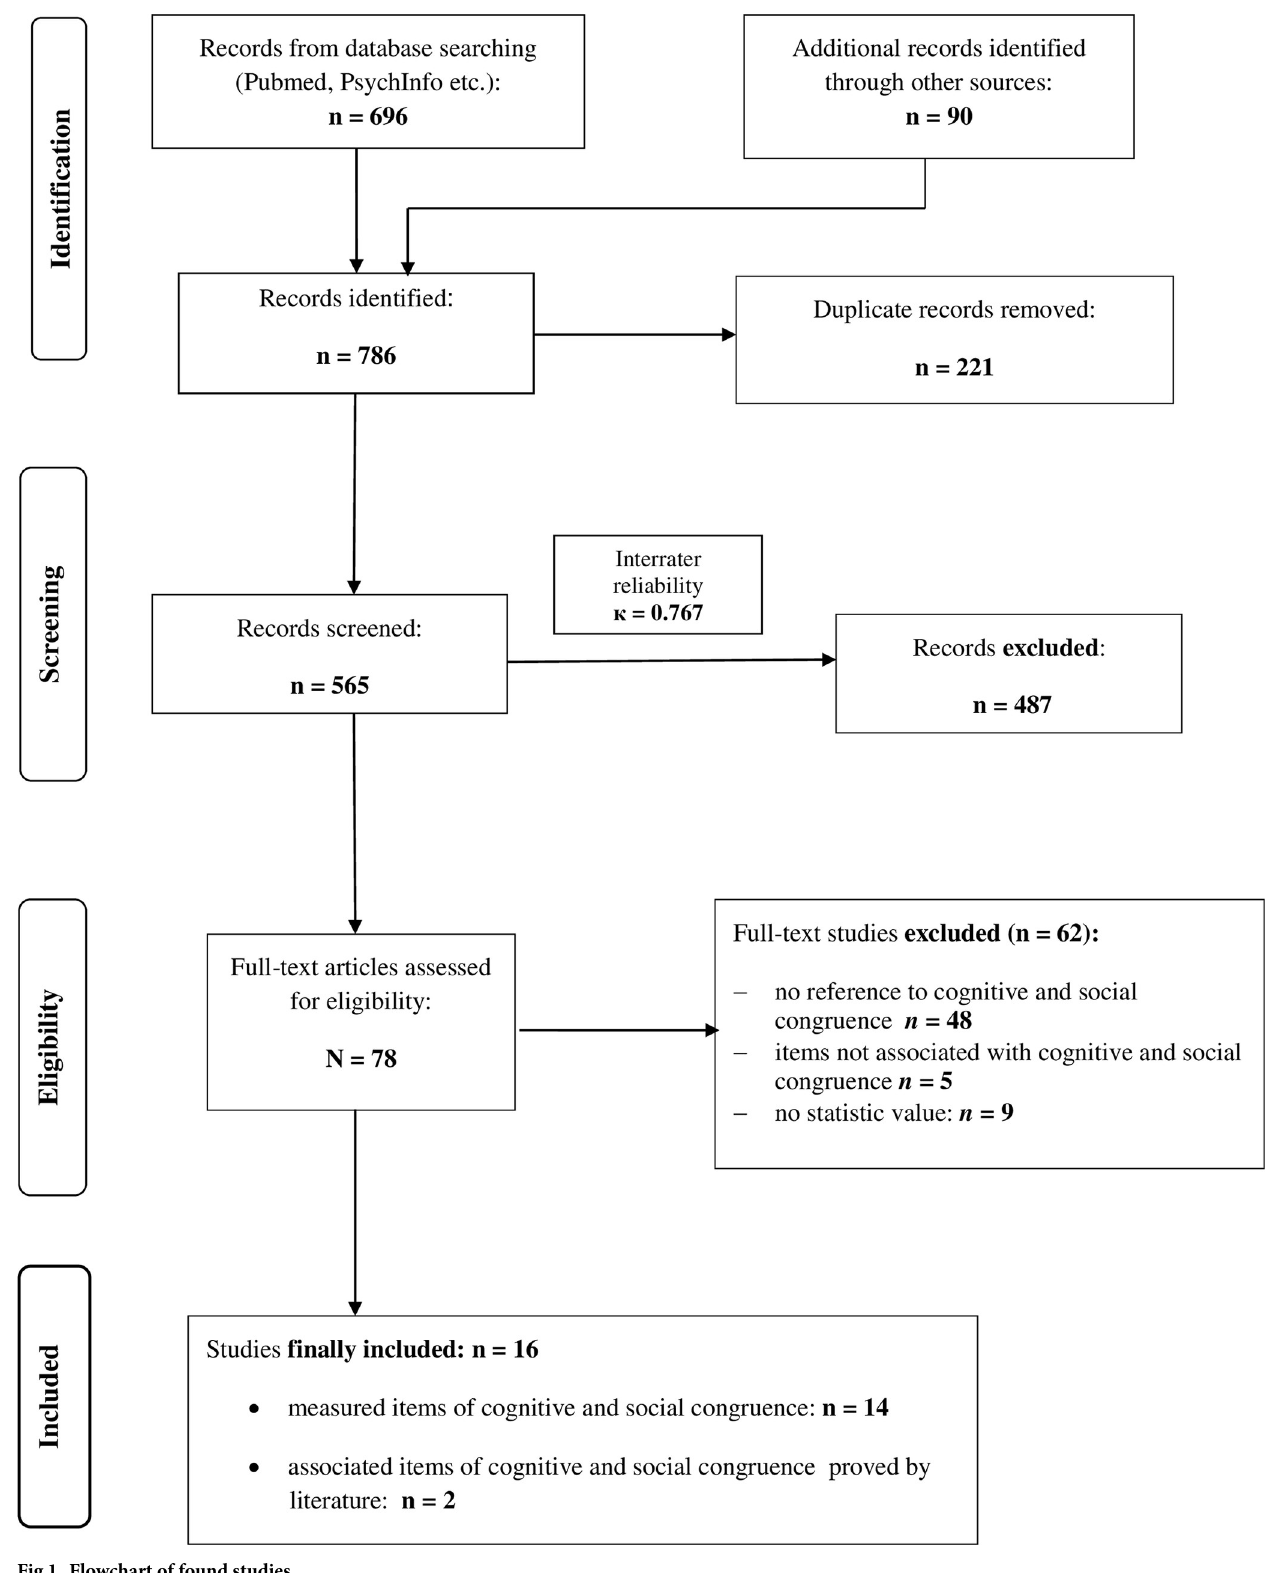
Fig 1. Flowchart of found studies.